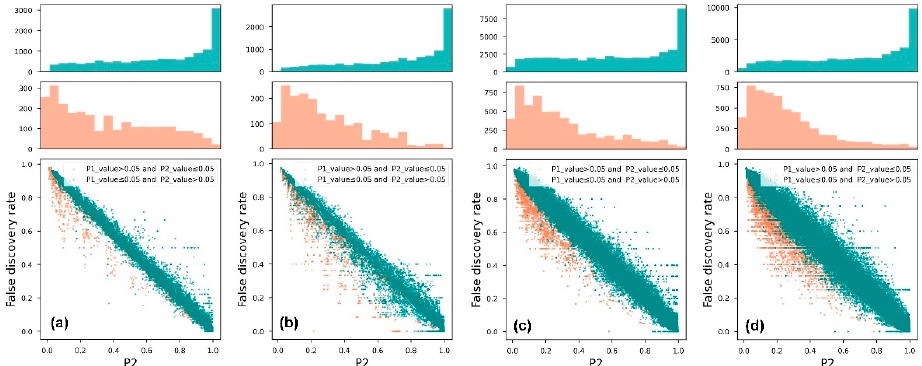
Figure 17. The relationship between P2 and the FDR, where P2 represents the average prior probability that all alarms can successfully predict an earthquake: ( a , b ) represents the results when the resampling window scale is 50 km and 100 km, respectively; ( c , d ) the results when the moving window scale is 50 km and 100 km, respectively.